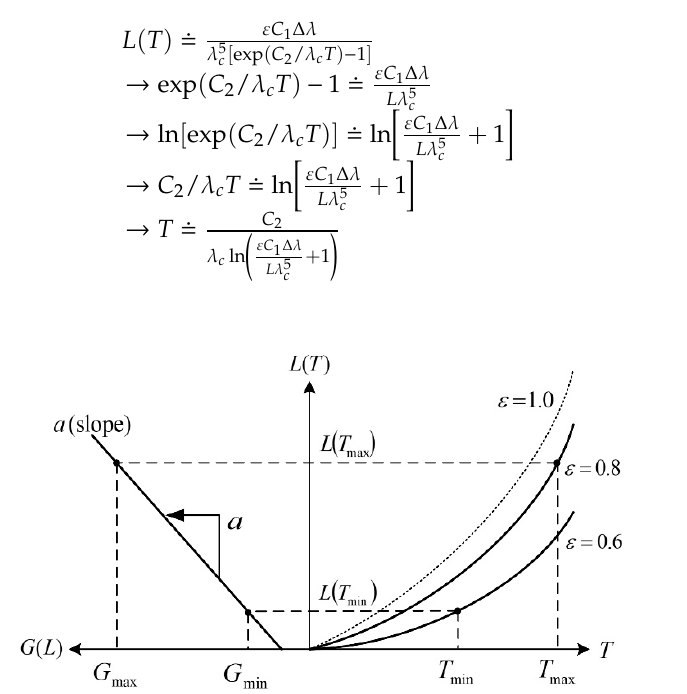
Figure 4. Relation between radiance and gray level of infrared (IR) image according to object temperature.